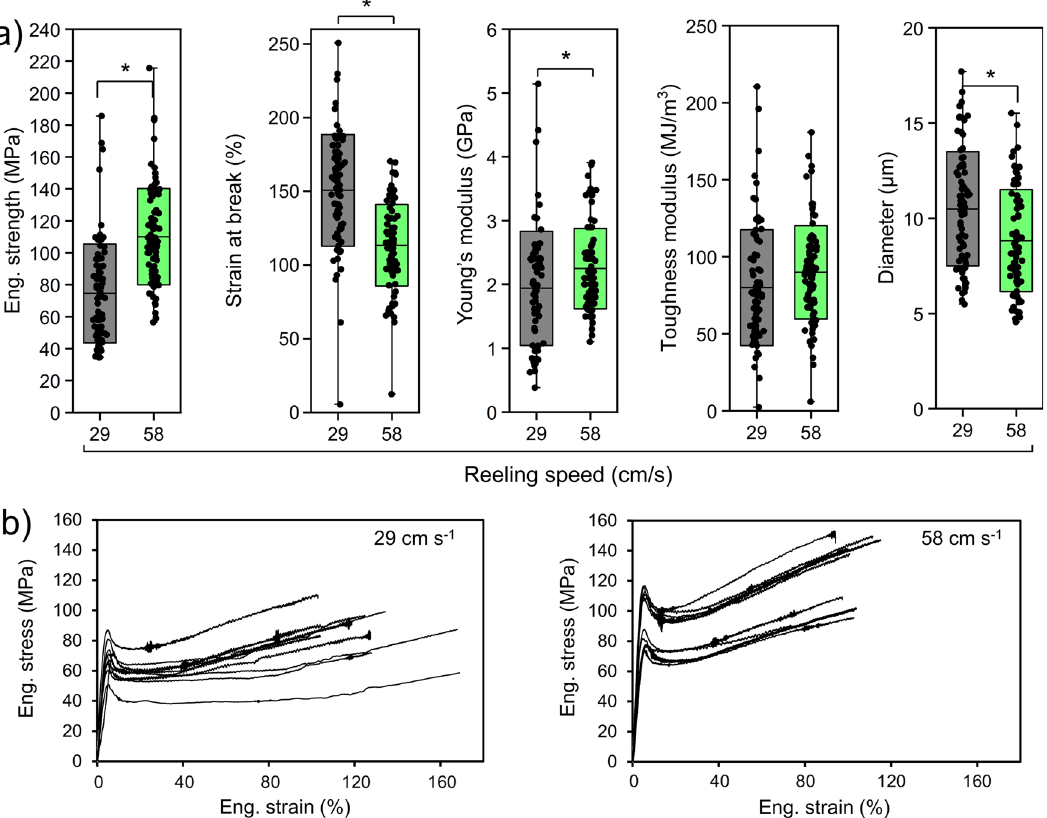
Fig. 6 The mechanical properties of NT2RepCT fi bers spun at 29 and 58 cm/s at several different occasions. a 79 fi bers spun at 29cm/s at 6 different occasions, and 89 fi bers spun at 59 cm/s at 8 different occasions were tensile tested. Whiskers indicate the minimal and the maximal value, the boxes show ±one standard deviation and the horizontal line in the middle of the boxes represents the mean value. A signi fi cant difference ( p < 0.05) is indicated with stars. The mean values for each individual spin highlighting the spin-to-spin variation are shown in Supplementary Fig. 15. b Representative stress- strain curves of both fi ber types spun at 29 cm/s and 59 cm/s are shown. Additional spinning parameters relevant to this experiment are found in Supplementary Table 2.